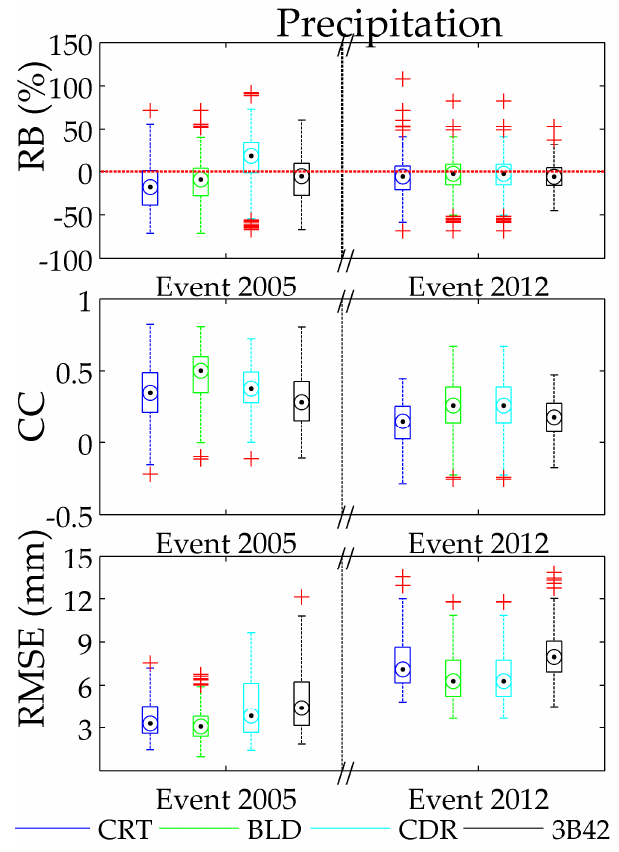
Figure 10. The boxplot of the statistical indicators of SGPEs against CMA data over the UYRB. Five lines from bottom to top for one box represent minimum value, 25th percentile, 50th percentile, 75th percentile, and maximum value, respectively.